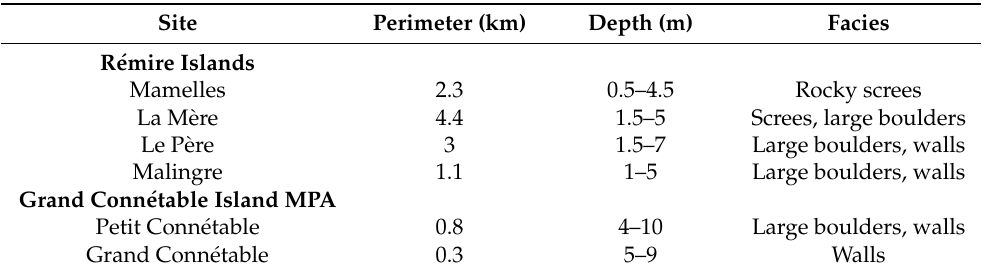
Table 1. Characteristics of R é mire islands and Grand Conn é table Island Marine Protected Area, rocky islands of French Guiana.